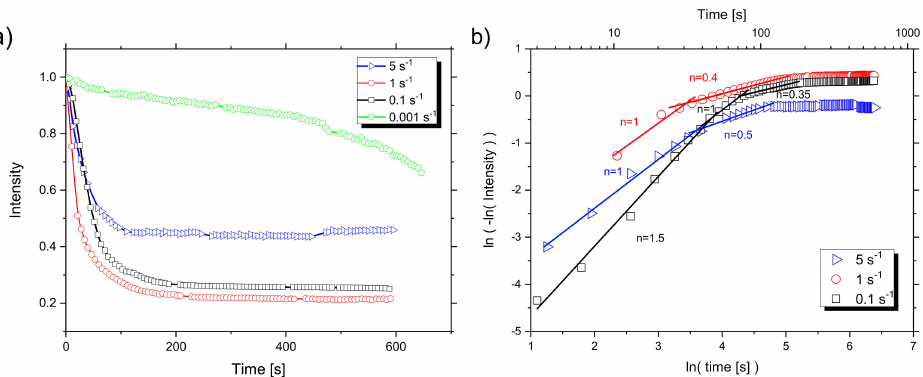
Figure 9. Normalized intensity evolution as a function of time during heat treatment after compression for the β -200 plane. ( b ) A double logarithmic scale of ( a ) after Equation (3). Straight lines indicate the linear fit and besides corresponding slopes ( n -exponent) are